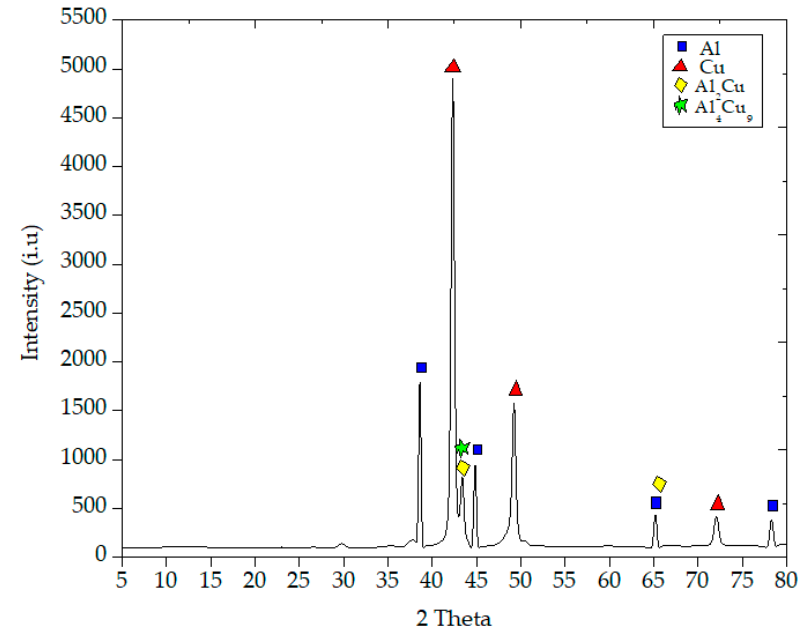
Figure 15. X-ray di ff raction (XRD) results from the cross-section of Al–Cu clad [Sample 14].